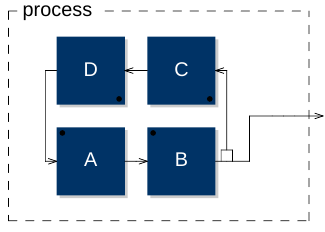
Figure 13. Bidirectional construction in F AUST using the tilde diagram composition